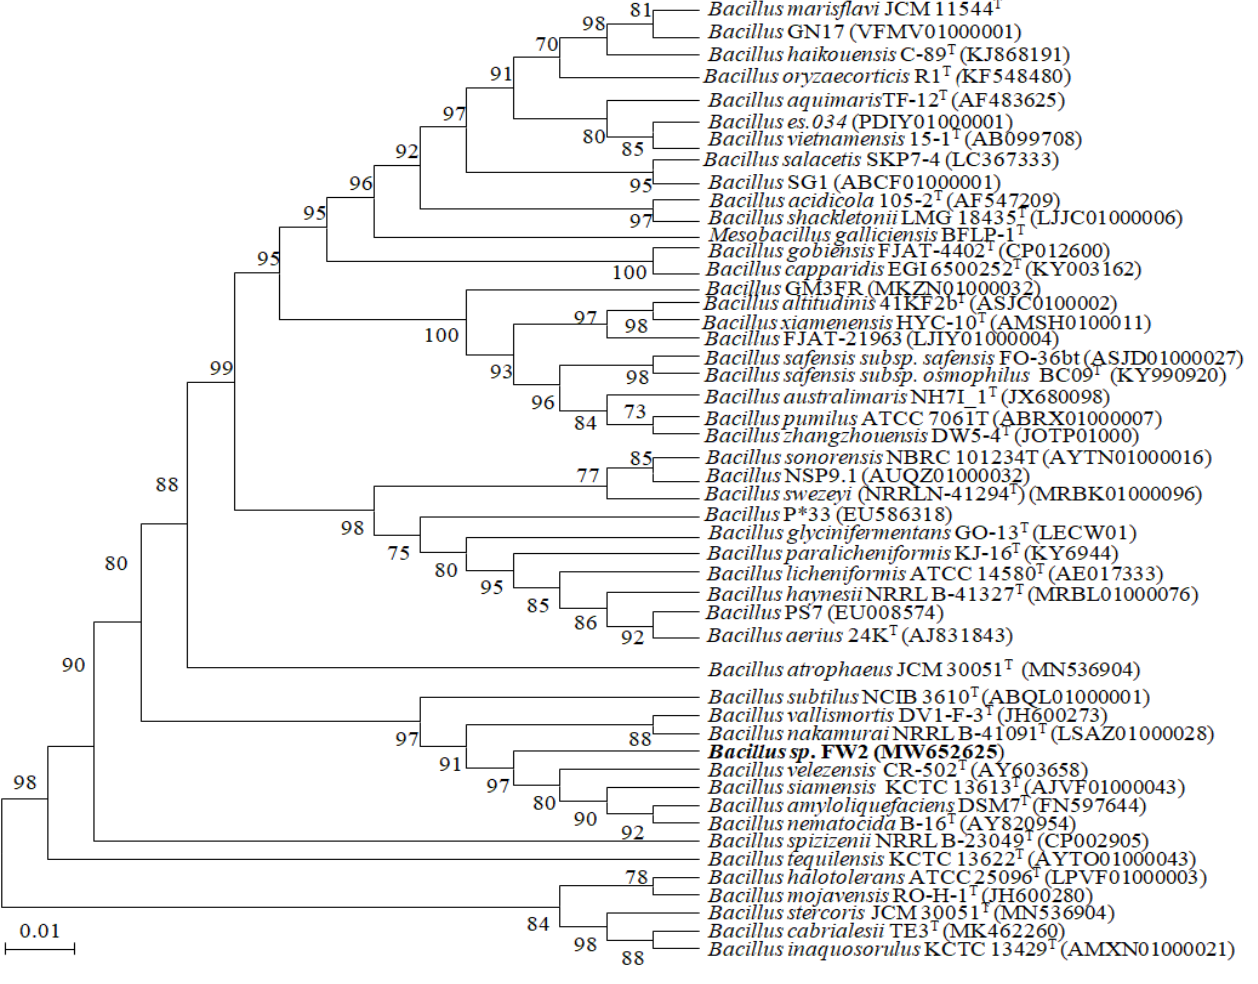
Figure 1. Phylogeny of 16S rRNA gene sequences of strain FW2 and related Bacillus genus members. The tree was constructed using the neighbor-joining method. Bootstrapping was carried out with 1500 replicates.